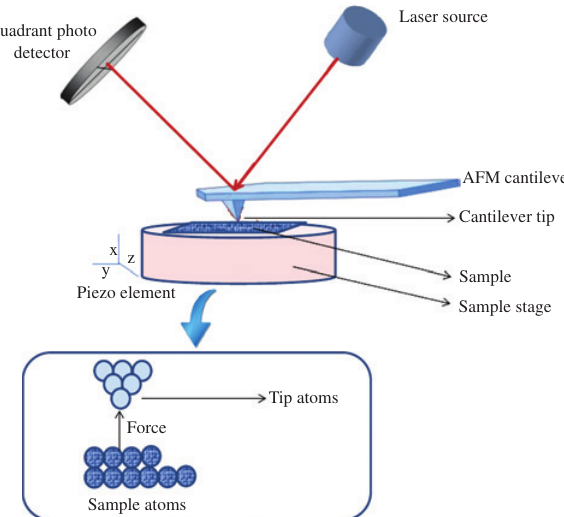
Figure 9: Representative assembly of an AFM